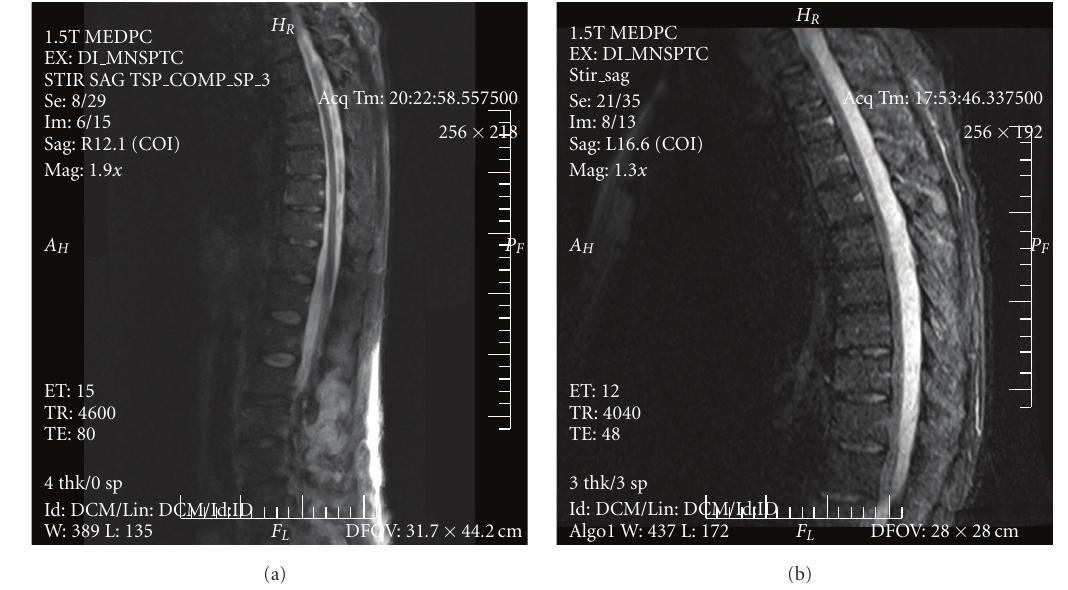
Figure 1: Saggittal thoracolumbar spine MRI with STIR (short T1/tau inversion recovery): day 1 (a) and day 11 (b). Serial MRI images of the thoracic and sacral spinal cord from hospitalization day 1 (a) and day 11 (b) using STIR (short T1/tau inversion recovery) sequences. Panel A shows a 12 × 3cm multiloculated abscess of the right paraspinal musculature in the L2–L5 region, and subtle enhancement of the L3-L4 transverse processes, consistent with osteomyelitis. There is no epidural abscess. The MRI in (b) shows extensive rim enhancement of the epidural column and severe anterior compression of the spinal